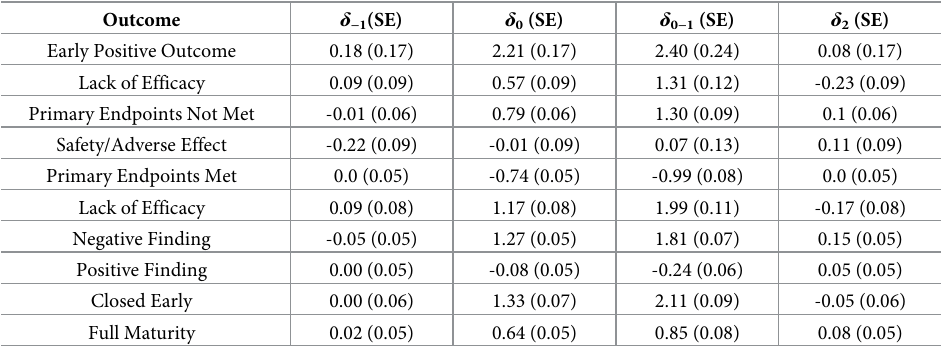
Table 2. Outcome